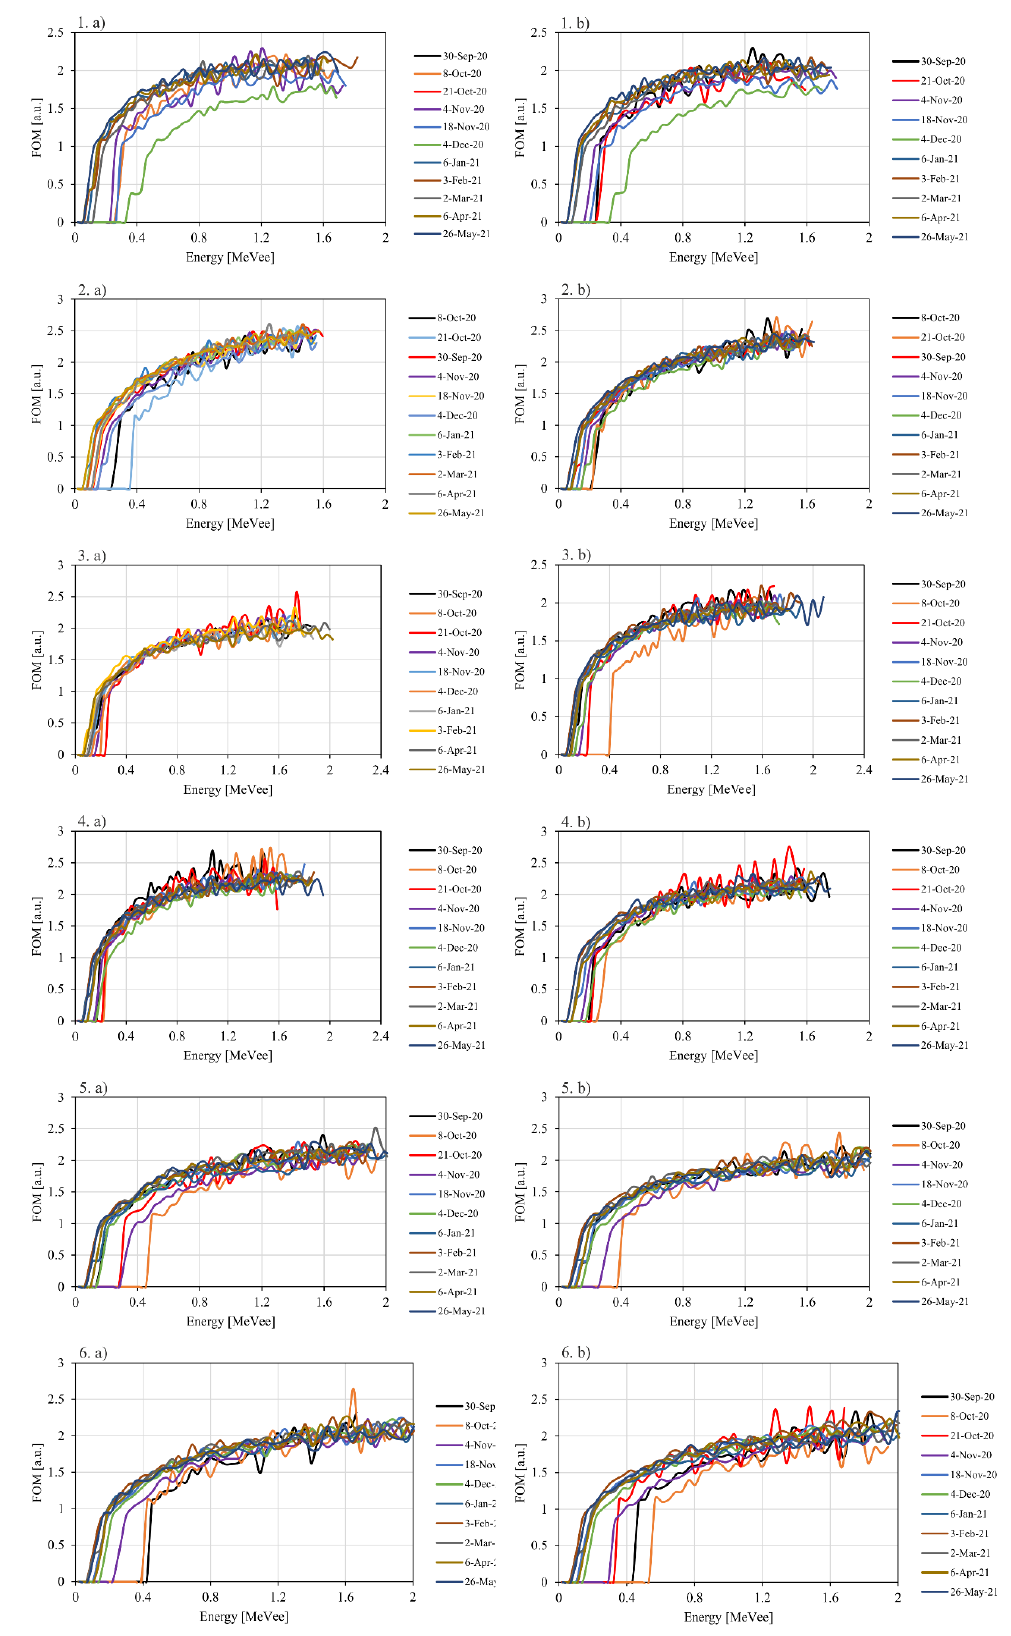
Fig. 1. The gamma-neutron separation of EJ301 (1), EJ309 (2), PYR 2 (3), PYR 5 (4), THIO 2 (5), and THIO 2 (6) scintillation cocktails prepared under nitrogen (a) and ambient (b) atmosphere expressed in